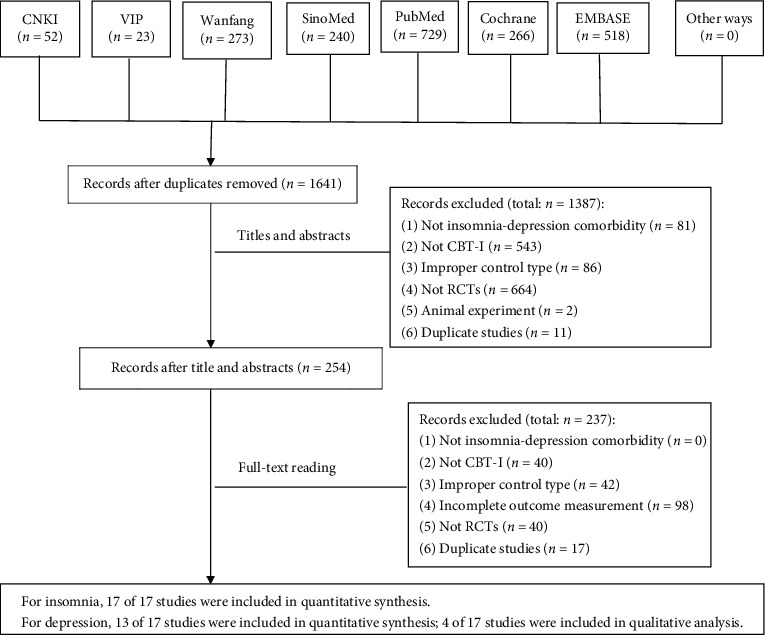
Study flow diagram.